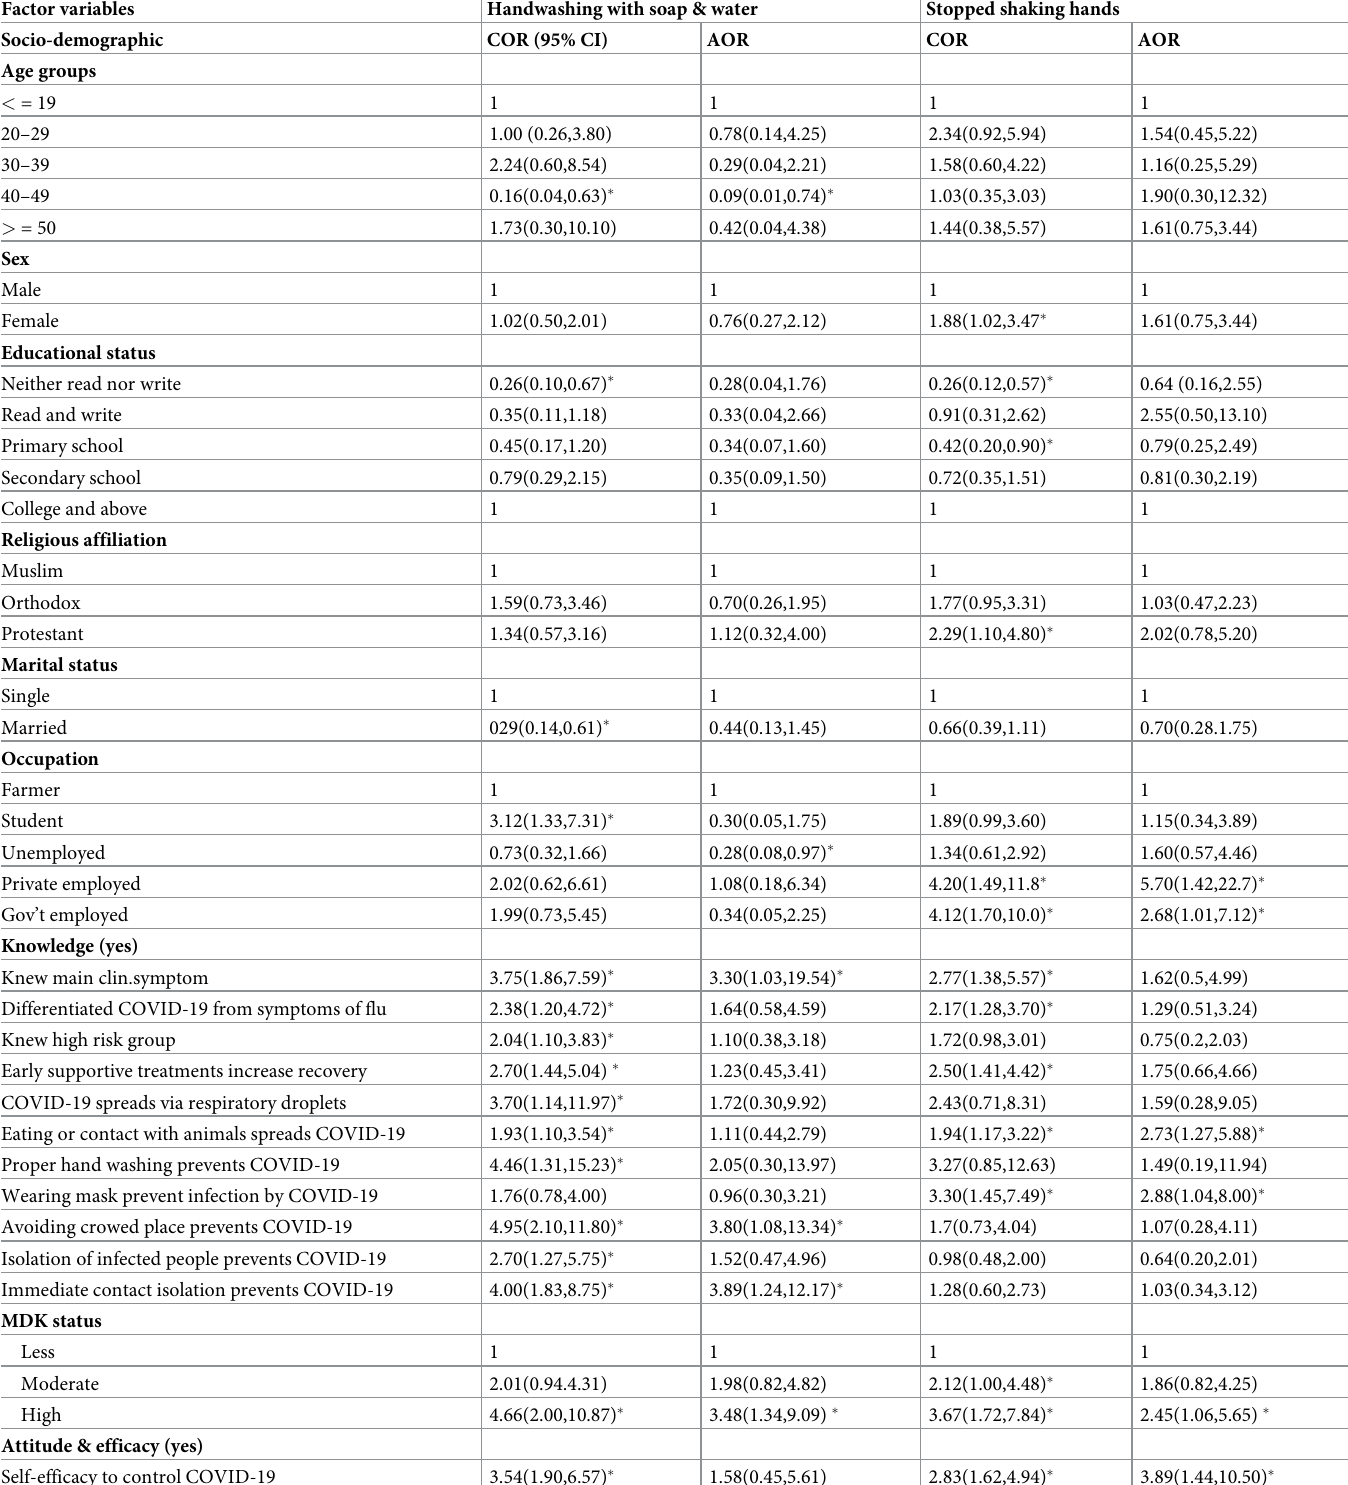
Table 4. Predictors of COVID-19 preventive measures, JUMC visitors, Jimma, March 2020 (n =